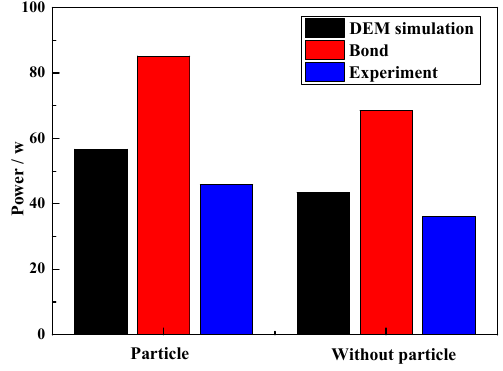
Figure 16. Power draw with and without particles.